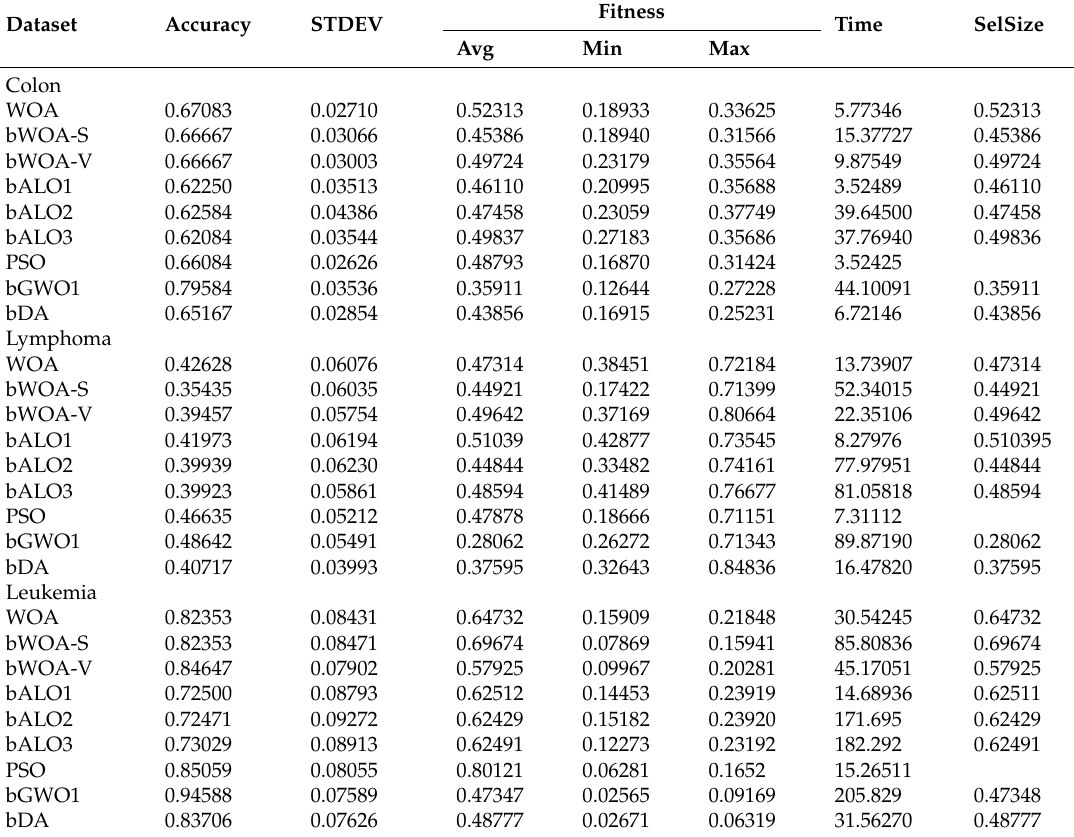
Table 9. Results for high dimensional datasets.